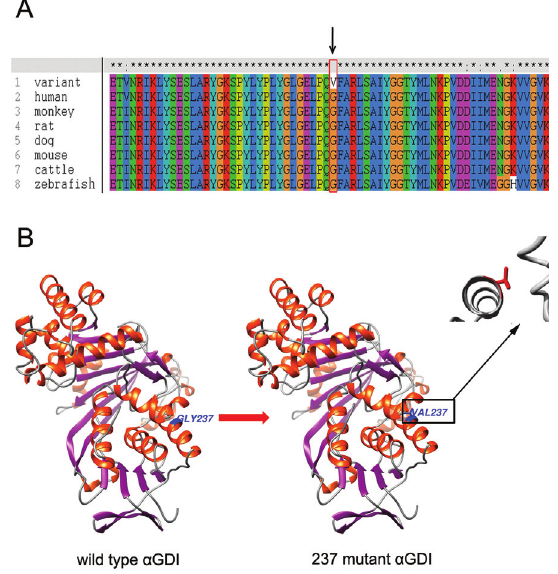
Figure 2 - The GDI protein. (A)The evolutionary conservation of the re- spectiveaminoacidsequencesbetweenseveralvertebratesandhuman,ar- row points to the 237 residue.(B)The 237 position amino acid of GDI pro- tein was changed from glycine to valine (p.Gly237Val).